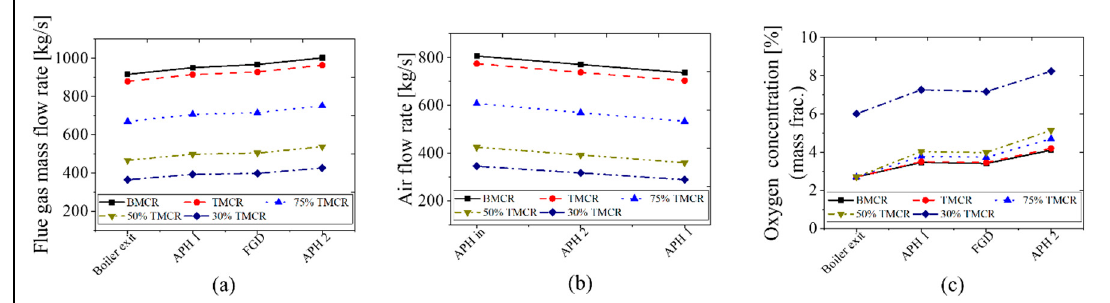
Figure 10. Mass flow rate of flue gas and air, and the oxygen concentration in the new process based on the five load conditions: ( a ) flue gas mass flow rate, ( b ) air flow rate, and ( c ) oxygen concentration.